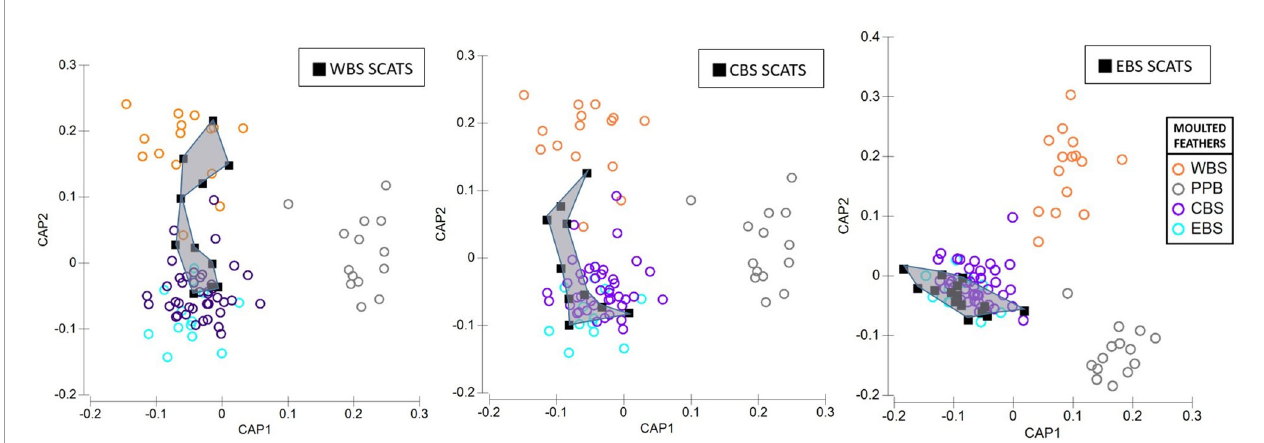
FIGURE 8 | Canonical variate plots of the multi-elemental and isotope chemistry of feathers sampled from colonies of little penguins across Western (WBS), Central (CBS), Eastern Bass Strait (EBS), and Pt. Phillip Bay (PPB) (indicated by circles). Squares with convex hulls represent feathers retrieved from long-nosed fur seal scats sampled from (A) Cape Bridgewater (WBS), (B) Kanowna Island (CBS) and (C) Gabo Island (EBS).